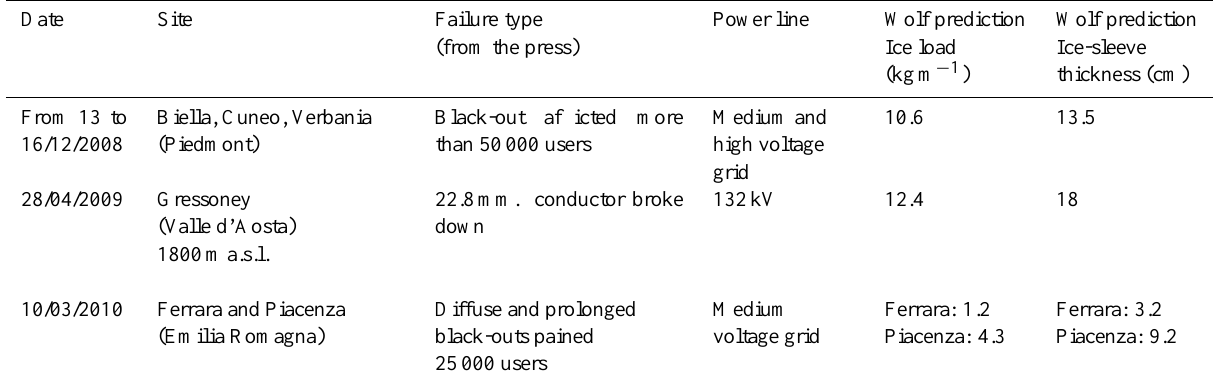
Table 1. Principal electrical accidents occurred during the WOLF simulation